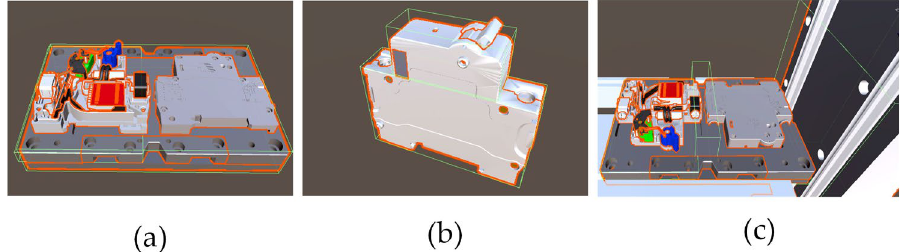
Figure 21. Model bounding volume handling: ( a ) The directional bounding volume; ( b ) The double- layer construction bounding volume; ( c ) The axis-aligned bounding volume.